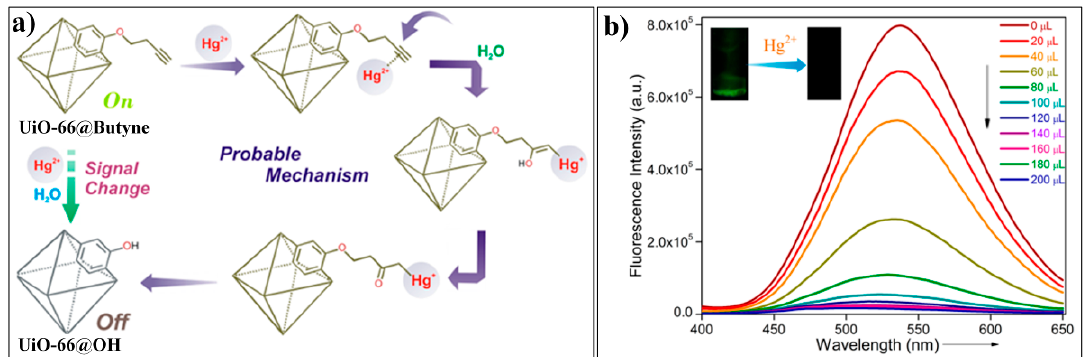
Figure 21. ( a ) Schematic illustration of the sensing mechanism of UiO-66@Butyne for Hg 2+ . ( b ) Figure21. ( a )SchematicillustrationofthesensingmechanismofUiO-66@ButyneforHg 2 + . ( b ) Fluorescence Fluorescence spectra of UiO-66@Butyne upon addition of different amount of Hg 2+ . Reproduced spectra of UiO-66@Butyne upon addition of different amount of Hg 2 + . Reproduced with permission with permission from [157]. Copyright American Chemical Society, 2018. from [157]. Copyright American Chemical Society,